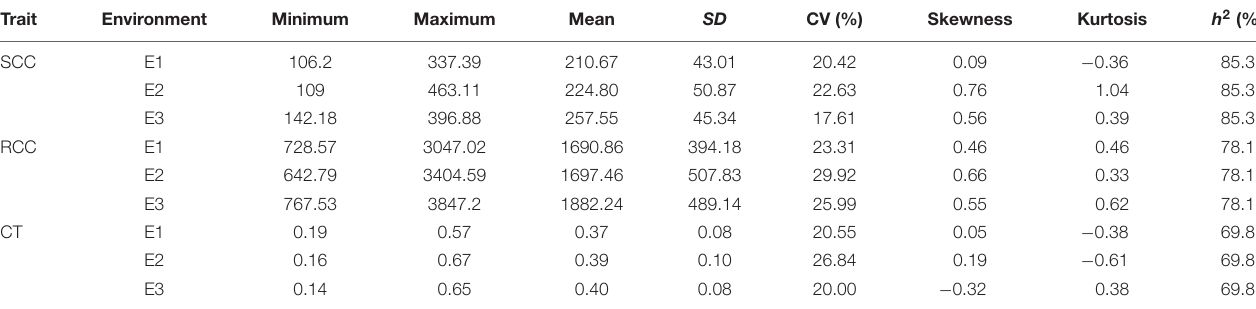
TABLE 2 | Phenotypic correlations between the Cd accumulation traits based on the trait mean values of plants grown in the three environments. SCC1